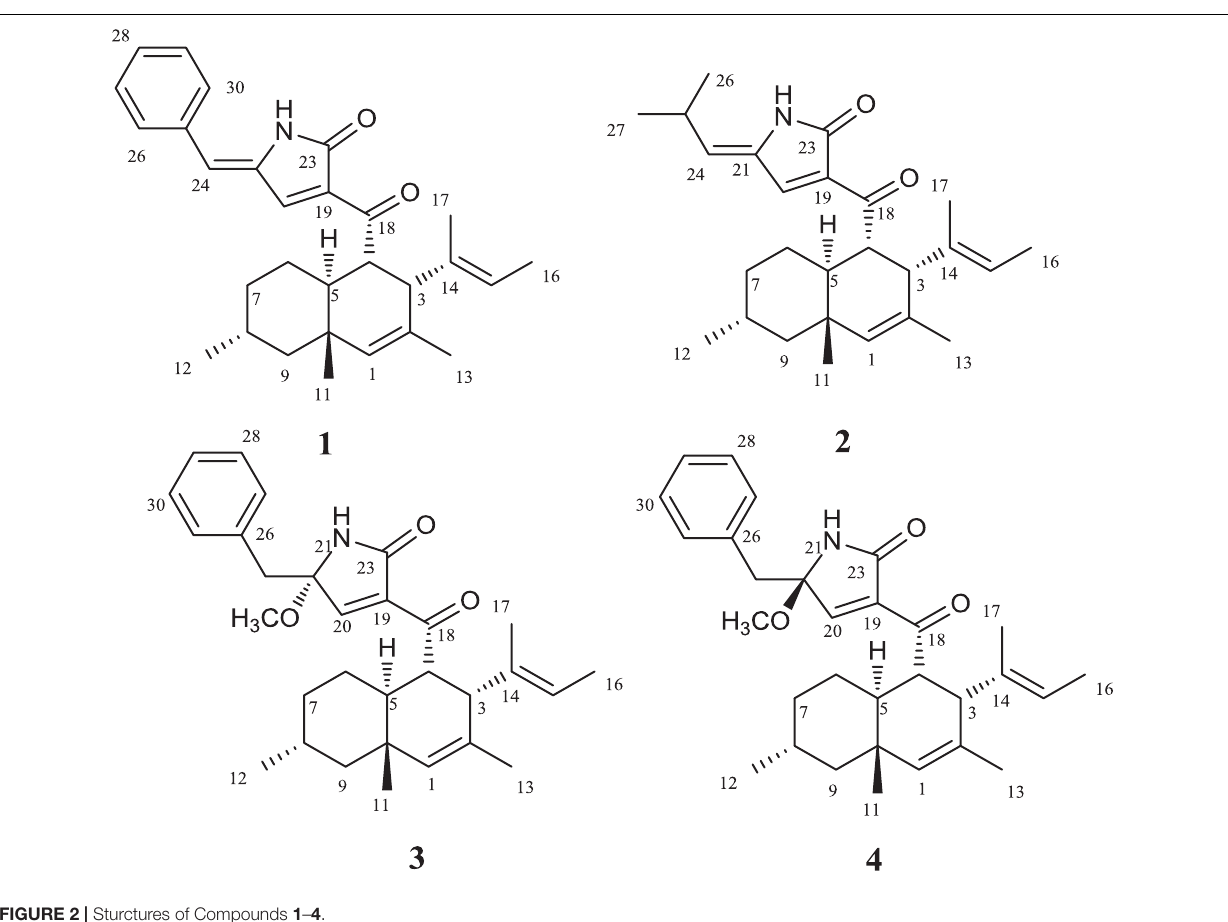
FIGURE 2 | Sturctures of Compounds 1 – 4